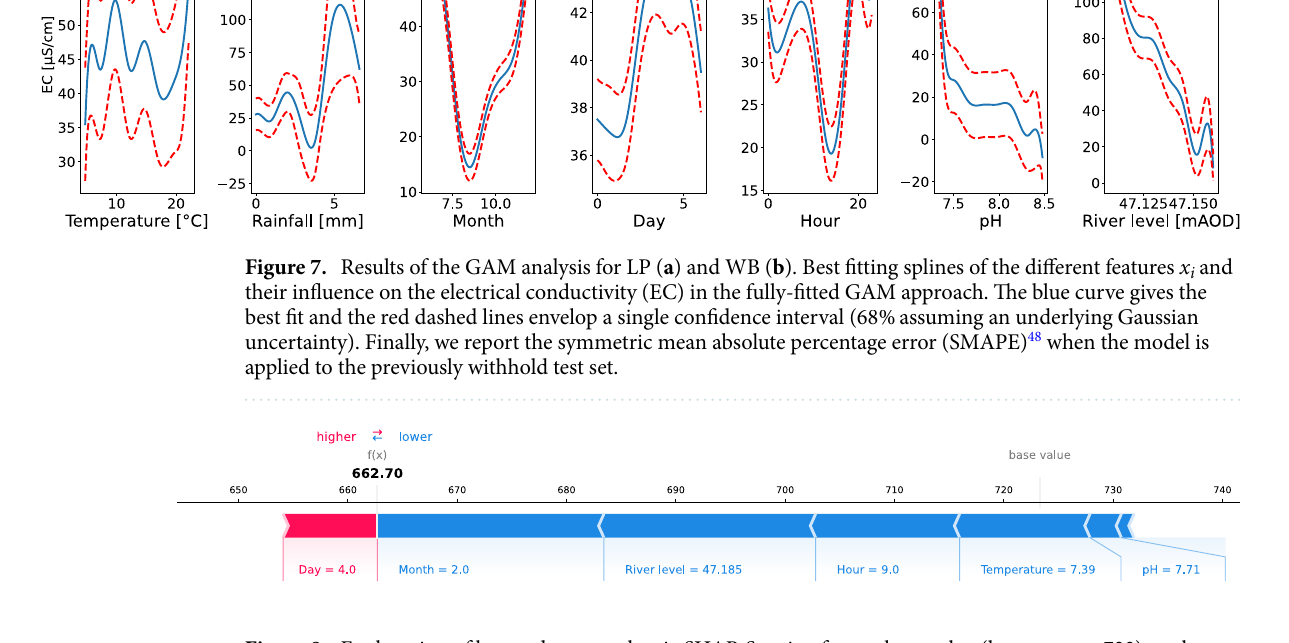
Figure 8. Explanation of boosted tree results via SHAP. Starting from a base value (here approx. 723), each feature pushes the prediction for the electrical conductivity value to lower (blue) or higher (red) values relative to the base value (ensemble average). Here, we explain one EC measurement at the LP measurement site via